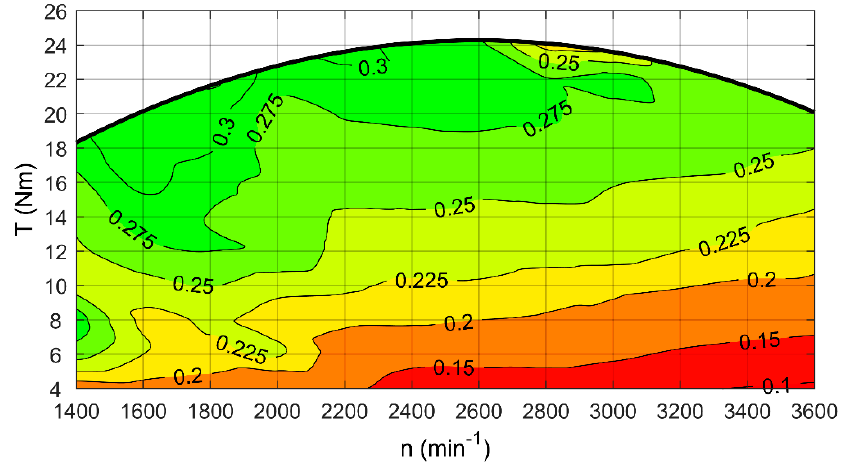
Figure 8. Thermal e ffi ciency of the range extender supplied with LPG. Figure 8. Thermal efficiency of the range extender supplied with LPG. Figure 8. Thermal efficiency of the range extender supplied with LPG.